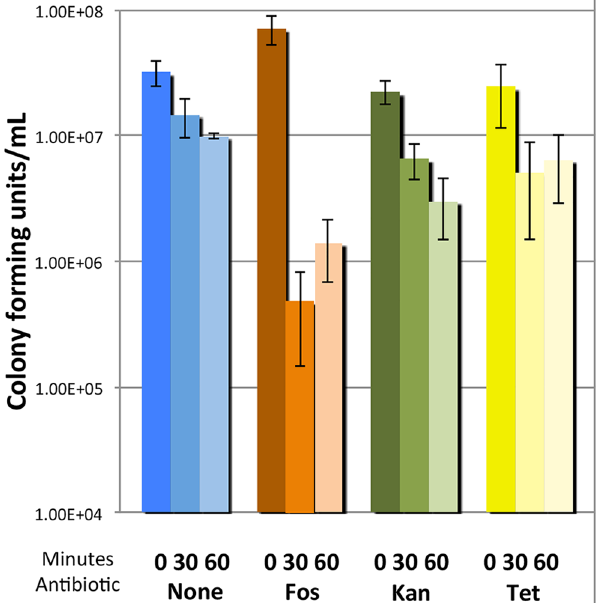
Figure 4. Cell viability of antibiotic challenged cells upon hydrogen peroxide exposure. Viable colony forming units/mL upon H 2 O 2 (10 mM) treatment for untreated control cells, or cells previously challenged with fosmidomycin, kanamycin or tetracycline. The data represents the average of three independent tests and the error reflects the standard error of the